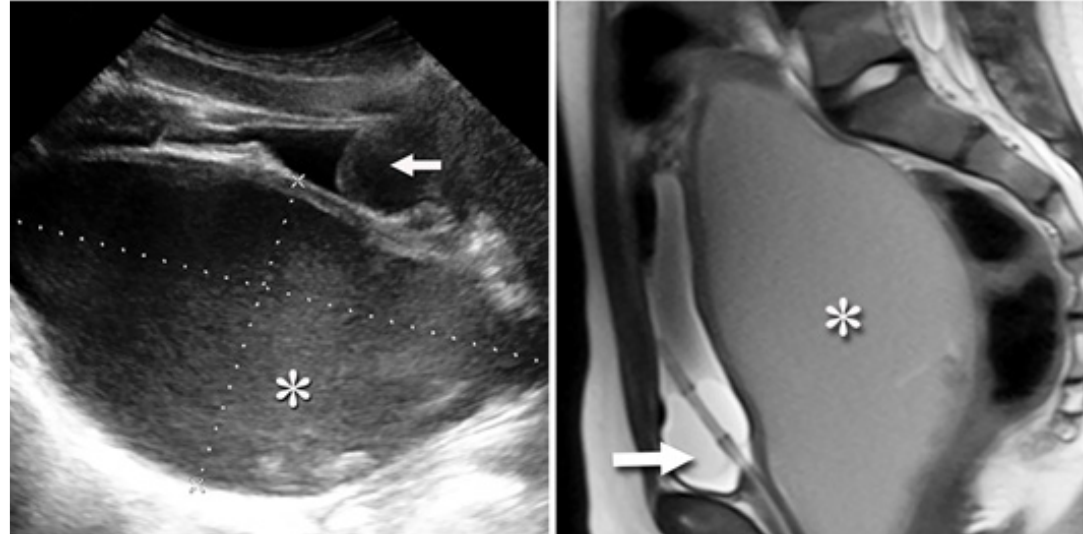
Figure . Long axis transabdominal sonographic view (left) of the patient’s abdomen revealing intrauterine low-level echogenic material (asterisk) communicating with the vaginal vault and a Foley catheter within a decompressed bladder (arrow). Sagittal magnetic resonance image (right) demonstrating fluid-filled distention (asterisk) of the patient’s uterus and vagina to the level of the introitus and a Foley catheter within the decompressed bladder